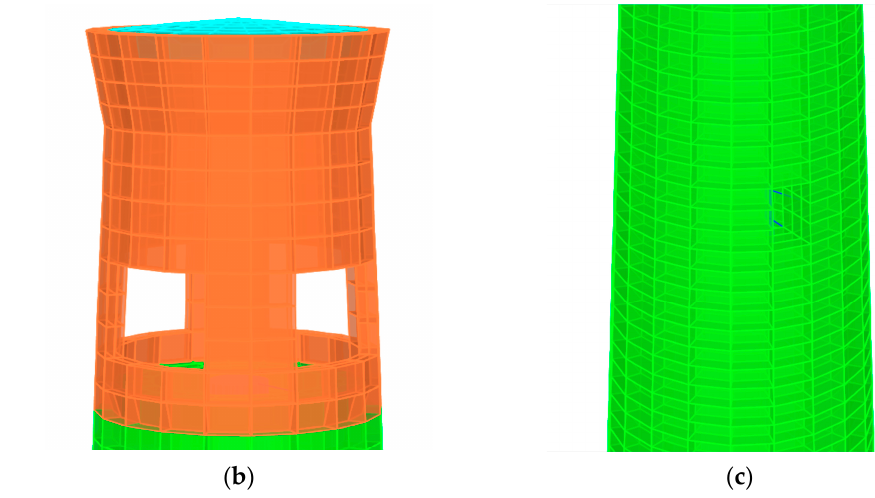
Figure 18. Details of the final model: ( a ) overall view; ( b ) core tower only; ( c ) typical window opening.